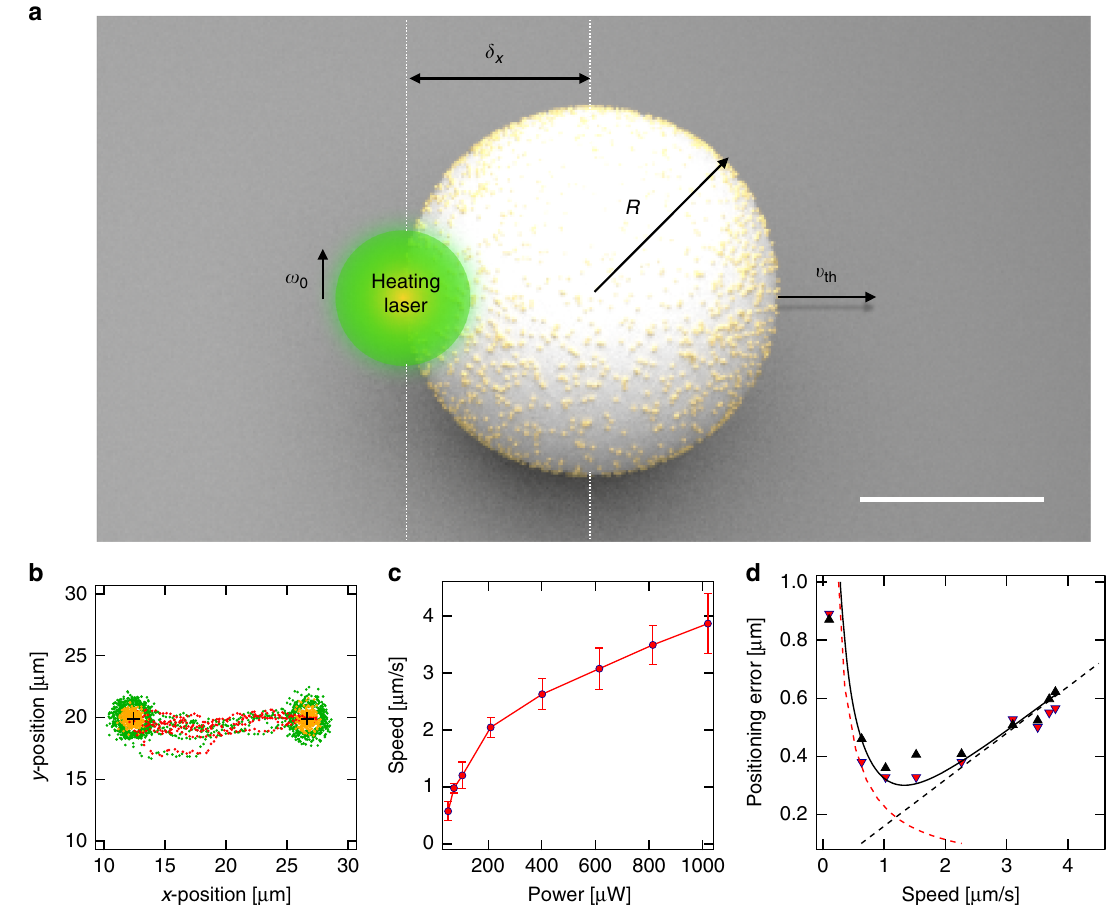
Fig. 1 Symmetric self-thermophoretic active particle and its properties. a Scheme of the self-thermophoretic active particle composed of a melamine resin particle ( R = 1.09 μ m) covered at 30% surface area by 10 nm gold nanoparticles. The nanoparticles can be heated by an incident laser beam (beam waist ω fi le along the particle surface. This pro fi le causes a thermo-osmotic slip fl ow propelling the particle at 0 ) to generate an inhomogeneous temperature pro v δ x of the laser focus from the particle center. The scale bar has a th away from the laser. The velocity of the particle is determined by the displacement length of 1 μ m. b The particle velocity and control accuracy is derived from an experiment driving the particle between two target positions and con fi ning it for 100 frames at each position. Example trajectory points (laser positions (green), particle position during trapping (orange), particle positions during driving (red)) (see Supplementary Movie 1). c Extracted particle speed as a function of the heating power. The error bars re fl ect the standard deviations from at least driving periods as shown in Supplementary Fig. 5. The nonlinear dependence is analyzed in the Supplementary Information. d Control accuracy as a function of the particle speed determined from the experiment in Fig. 1b. The upwards and downwards triangles correspond to the data from the left and right target, respectively. The dashed lines are the contributions from the 2-dimensional sedimentation (red) and the particle overshooting (black). The solid black curve represents the sum of both